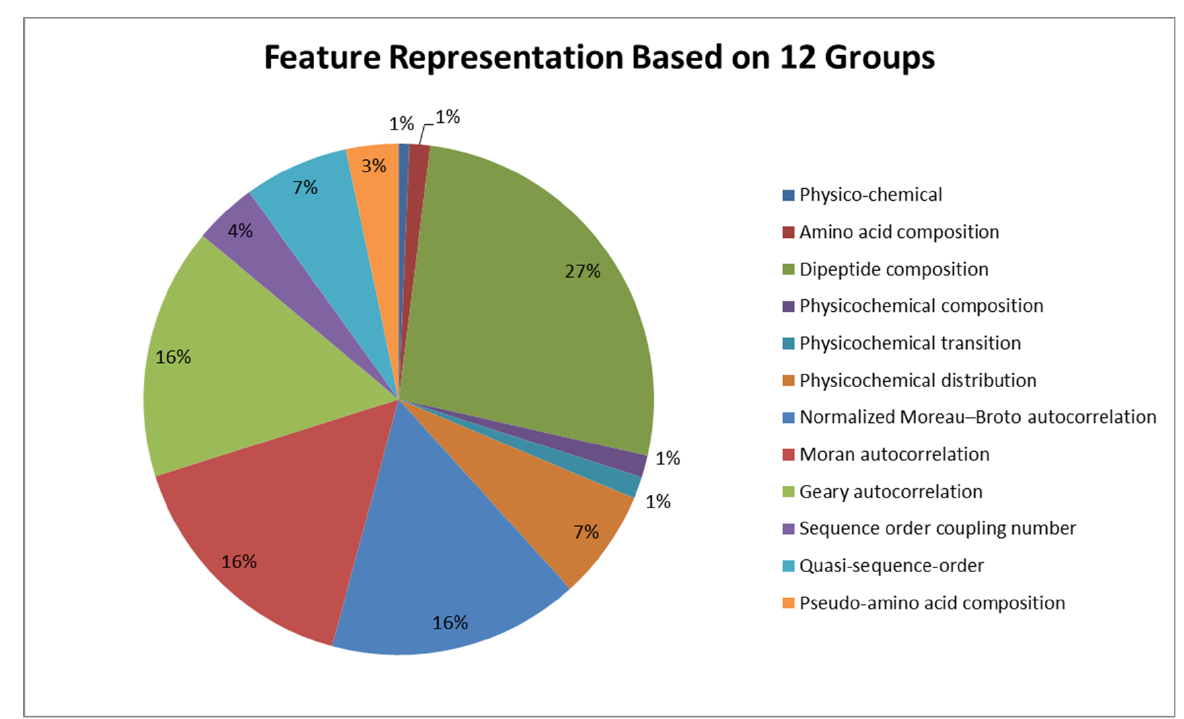
Figure 2. Feature representation based on di ff erent groups for antimicrobial peptides.